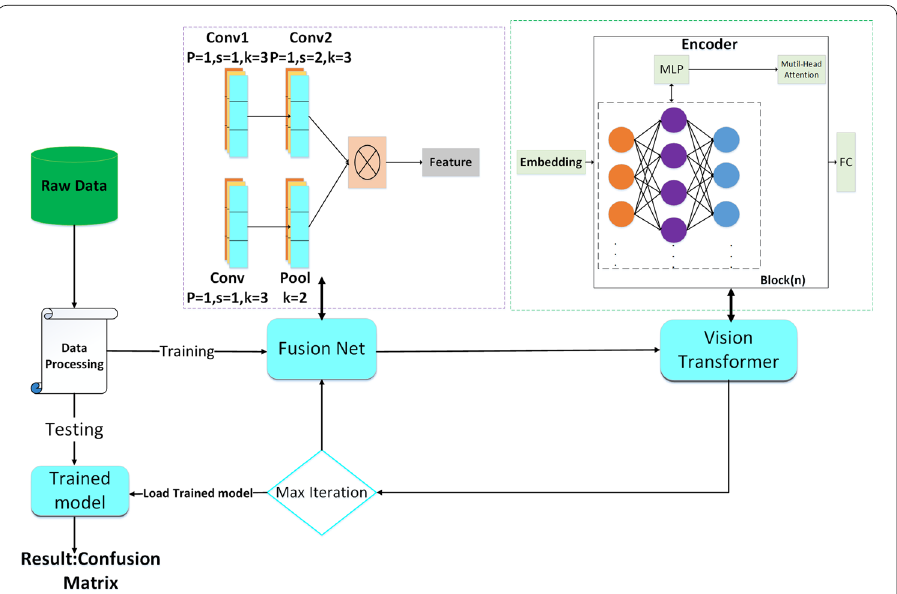
Fig. 1 Anomaly network traffic detection